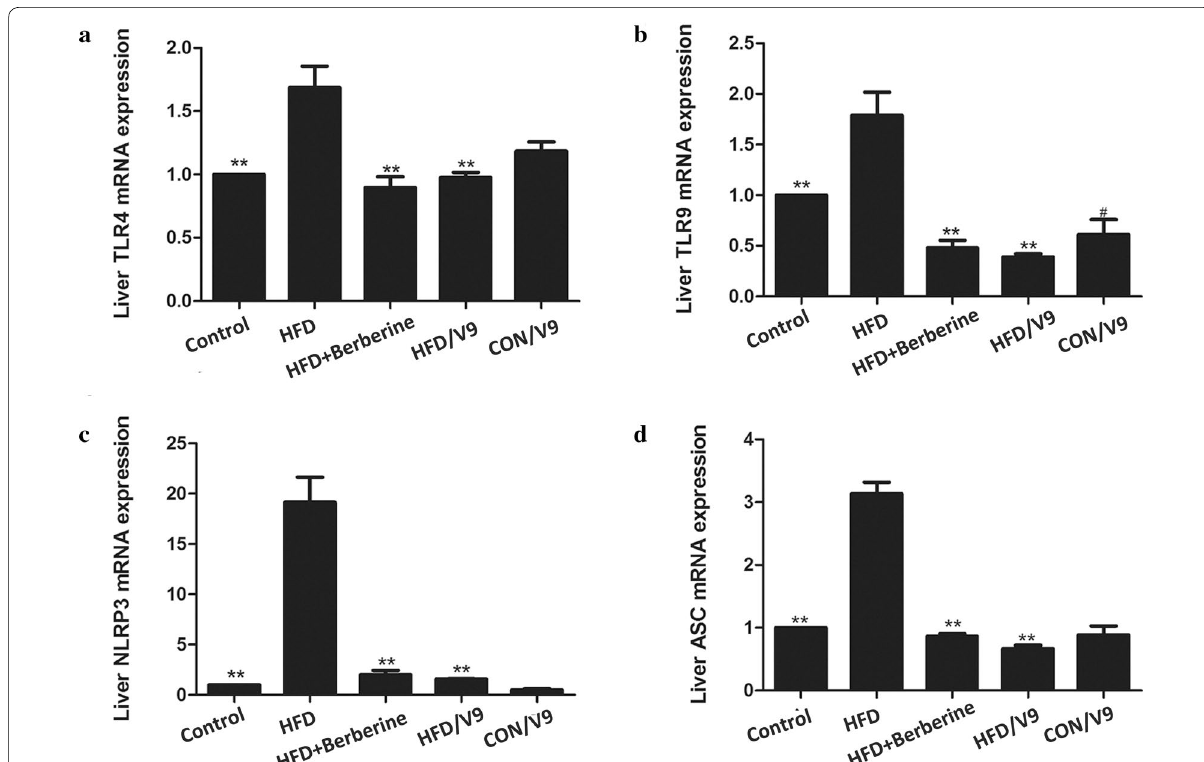
Fig. 5 The effect of Probiotic V9 on hepatic TLRs, NLRP3 and ASC. a Hepatic mRNA levels of TLR4. b Hepatic mRNA levels of TLR9. c Hepatic mRNA levels of NLRP3. d Hepatic mRNA levels of ASC. Data are expressed as mean